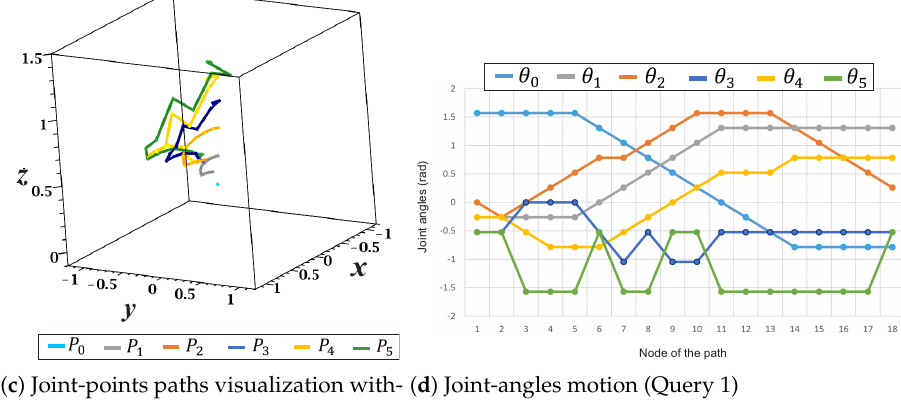
( c ) Joint-points paths visualization with- out obstacles (query 1). Figure 24. Joint-points paths and joint-angles motion (query